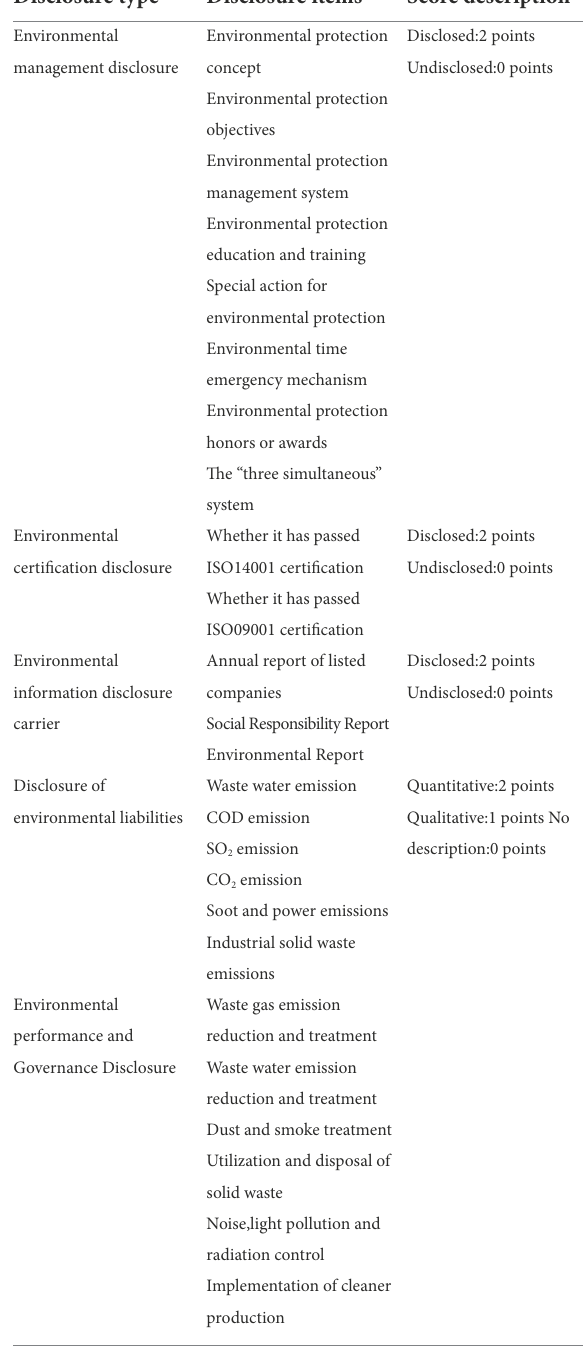
TABLE 1 Environmental information disclosure index rating